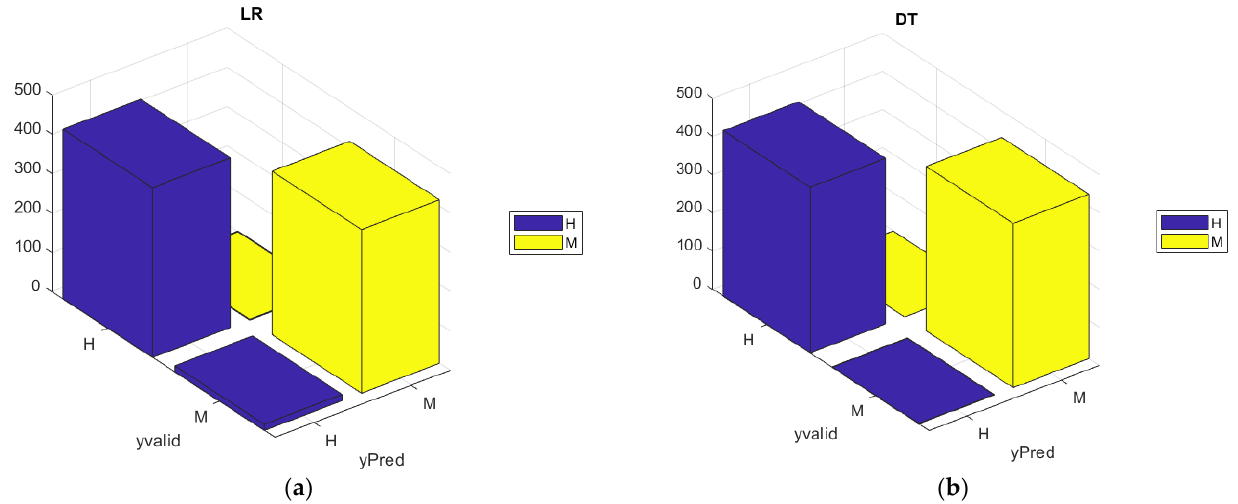
Figure 15. Confusion matrix of the prediction result: logistic regression method ( a ) and decision tree method ( b ).